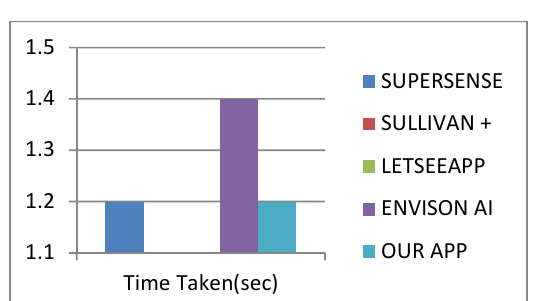
Fig 11 – Time taken by each application for face recognition